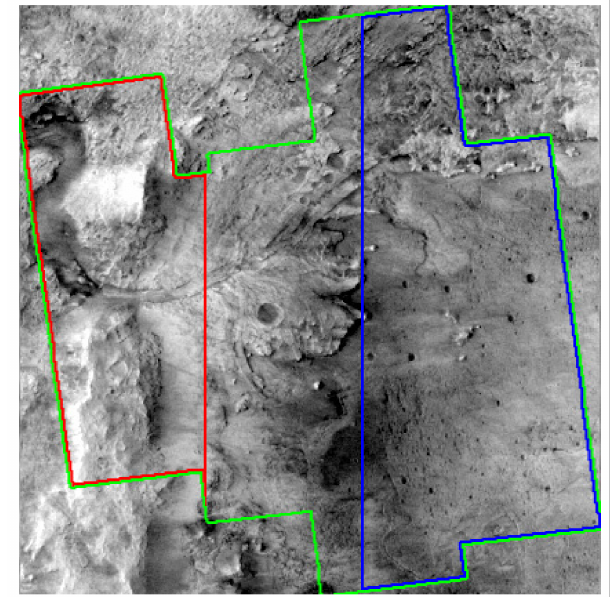
Figure 2. HRSC orthoimage of study area in Jezero crater, Mars, derived from h5270_0000 nadir image at 50 m GSD. Area covered by HiRISE reference DTM mosaic (root mean squared slope 7.09 ◦ ) is outlined in green, western rough (11.29 ◦ ) subarea in red, and eastern smooth (3.38 ◦ ) subarea in blue. Quality statistics for these areas are shown in Figure 6. Equirectangular projection with north at top, latitude of true scale 18.6 ◦ N. Area shown is 21.1 × 21.35 km, centered near 18.5 ◦ N, 77.4 ◦